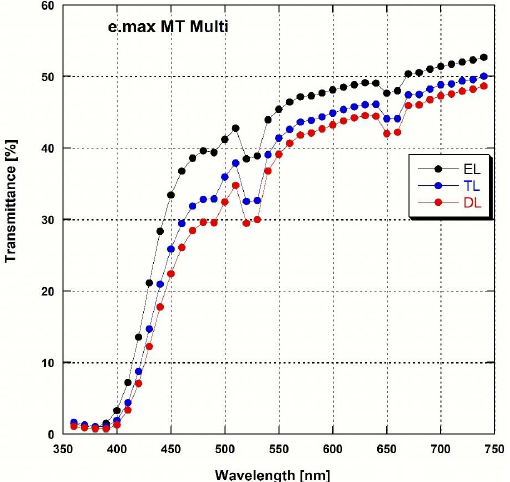
Figure 2. Spectral transmittance curves for each layer of the 4Y/5Y-zirconia (e.max MT Multi).